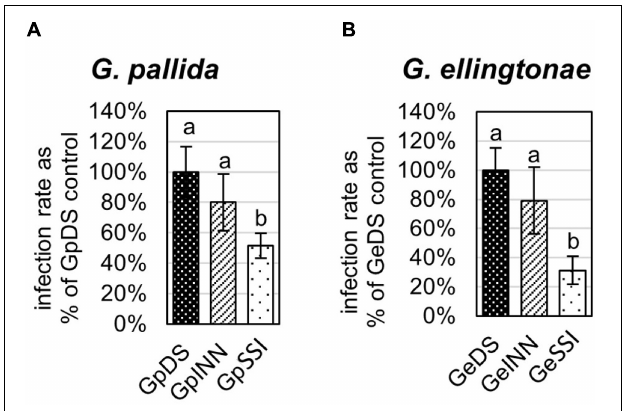
FIGURE 1 | Infection rate of (A) Globodera pallida or (B) Globodera ellingtonae on a susceptible potato cv. Desirée (DS) was measured as the percentage of value for a control DS hatching treatment. The number of infecting nematodes of both species was determined 14 days postinfection with J2s hatched in root exudates from susceptible potato control (cv. Desirée - DS), resistant potato (cv. Innovator - INN), or immune plant ( Solanum sisymbriifolium - SSI). Each value represents the mean ± SE from bulking samples of three independent experiments. Means having the same letter designation are not significantly different as determined using ANOVA followed by Tukey’s HSD test at p < 0.05.